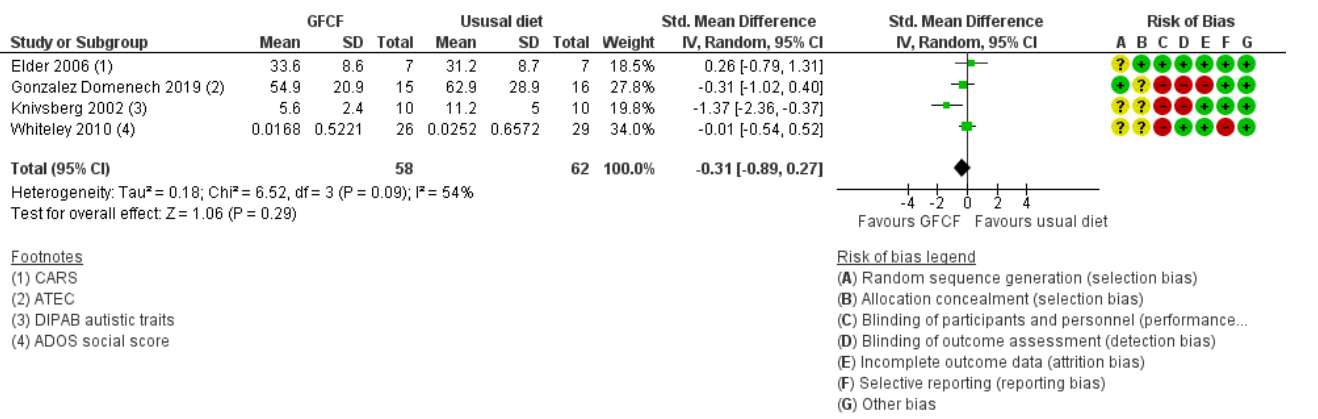
Figure 4. Forest plot of comparison: GFCF vs. usual diet, outcome: clinician-reported core symptoms.